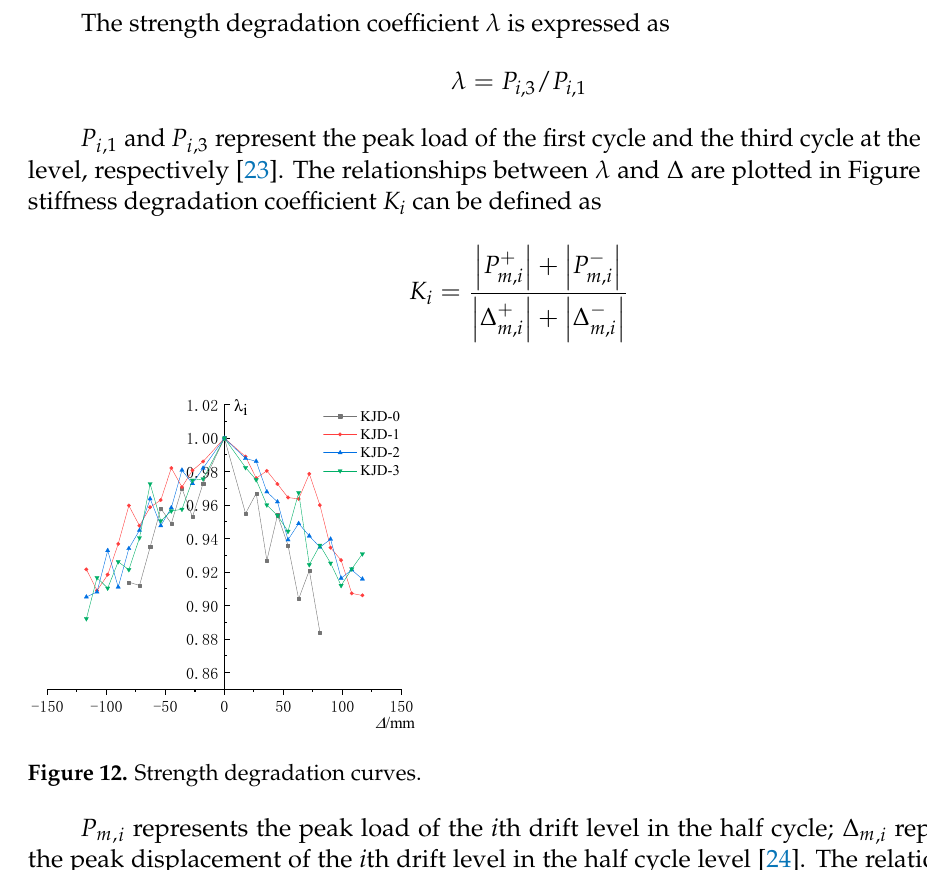
Figure 12. Strength degradation curves.